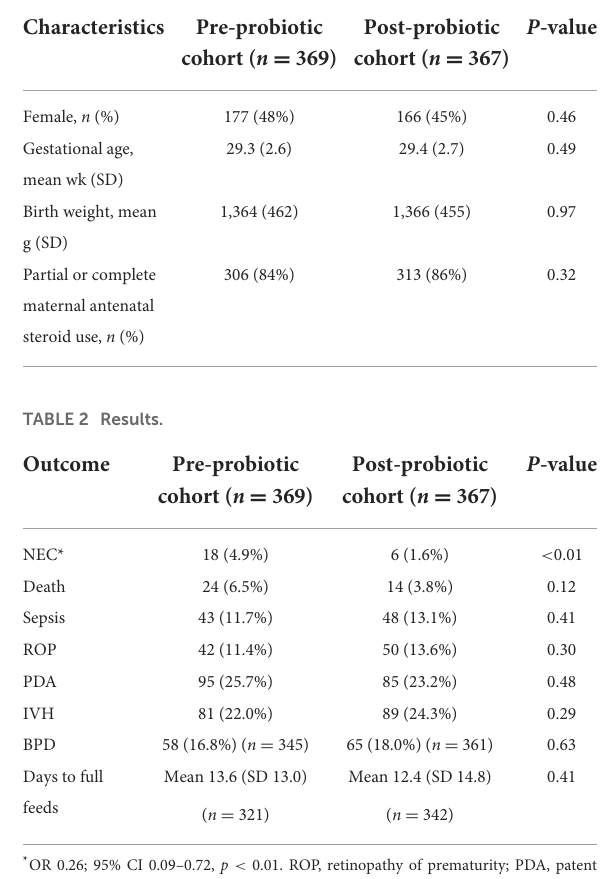
TABLE 1 Baseline characteristics.